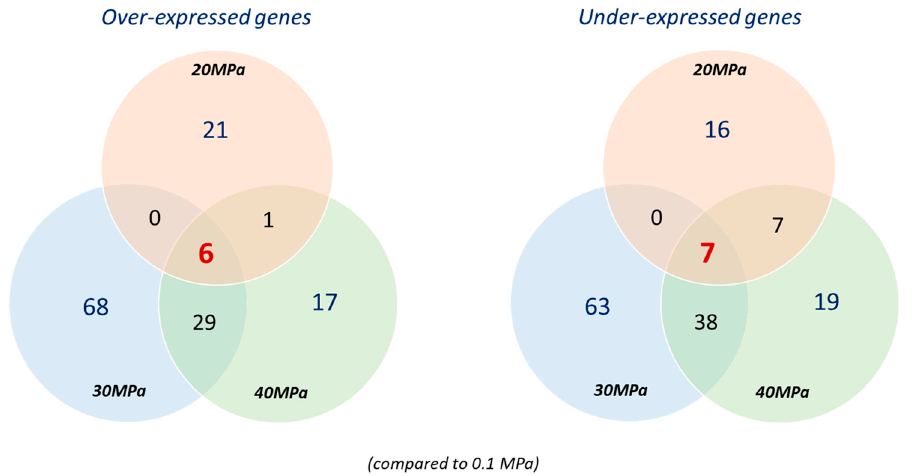
Figure 1. Venn diagram showing the number of significantly differentially expressed genes in the deep strain P. elfii DSM9442 when it was cultured at 20 MPa, 30 MPa, and 40 MPa compared to 0.1 MPa (adjusted p -value < 0.01, log 2 -fold change > 1.3).